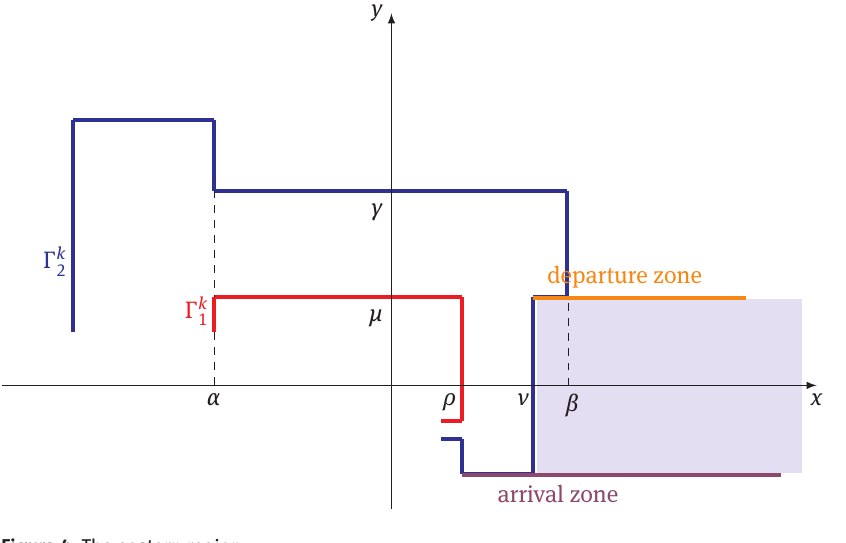
Figure 4: The eastern